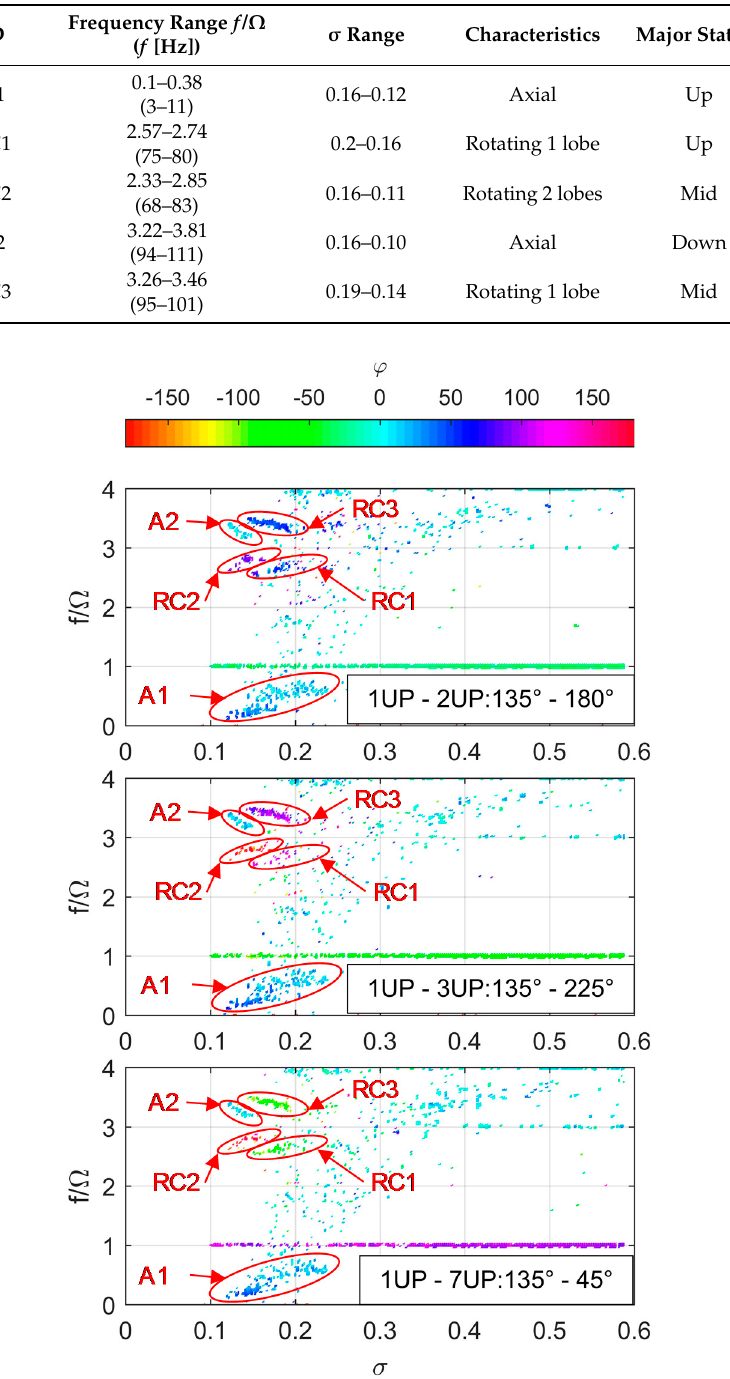
Figure 11. Cross-spectrum phase ( (cid:2030) ) of the midstream pressure transducers, Φ = 0.108 (90% Φ (cid:3005) ). circled phenomena are summarized in Table 8.